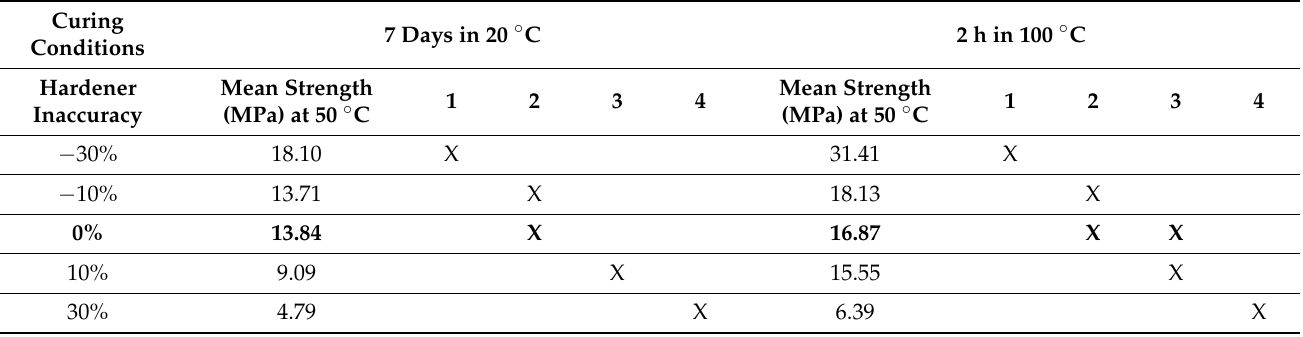
Table 4. Homogeneous groups (1-2-3-4, 1-2-3-4) of strength at 50 ◦ C for joints made with Epid- ian